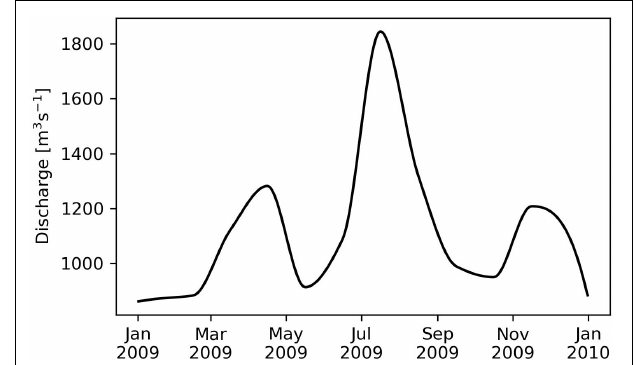
FIGURE 5 | Runoff of VR for 2009 from the Global Runoff Data